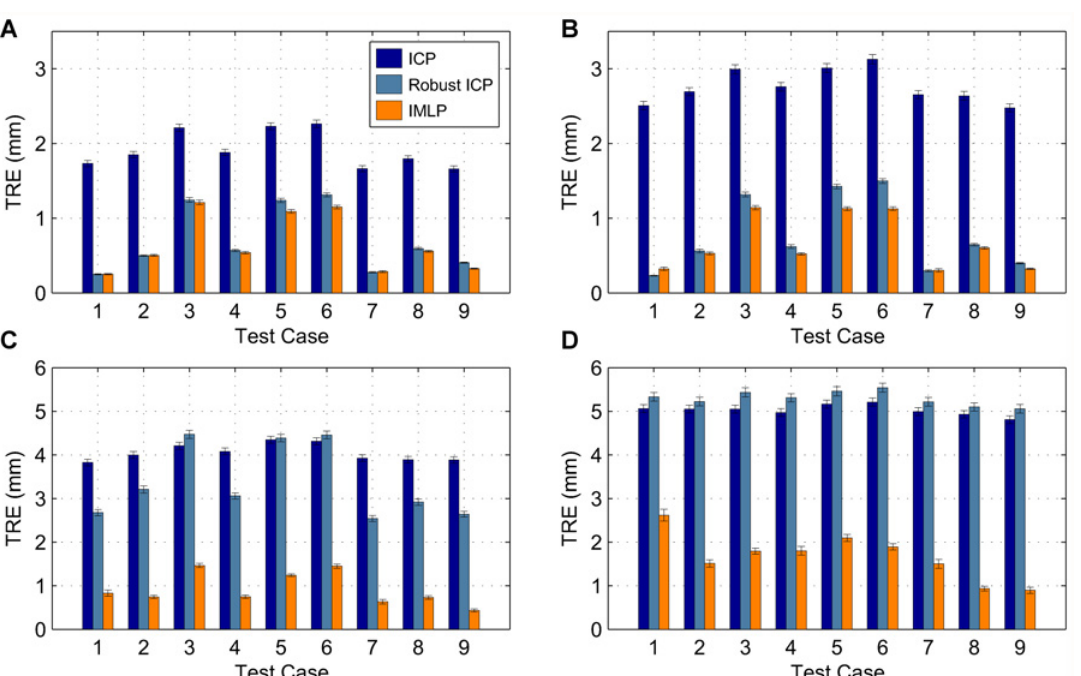
Fig 3. Registration errors for registering a source shape containing outliers to a mesh target under moderate misalignment. (Experiment 3A). Source shapes were randomly generated from the hip mesh (Fig. 1A), misaligned by [15, 30] mm / degrees, and registered back to the mesh. The test cases represent the different noise models used to generate noise on the source shape (Table 4). Outliers were added to the source shape constituting (A): 5%, (B): 10%, (C): 20%, and (D): 30% of the source points. For each test case, 300 randomized trials were conducted, with successful registrations being used to compute an average target registration error (TRE). The error bars provide approximate standard deviations of the reported average TRE values. The proposed IMLP algorithm was evaluated relative to standard ICP [1] and relative to a robust variant of ICP [4].